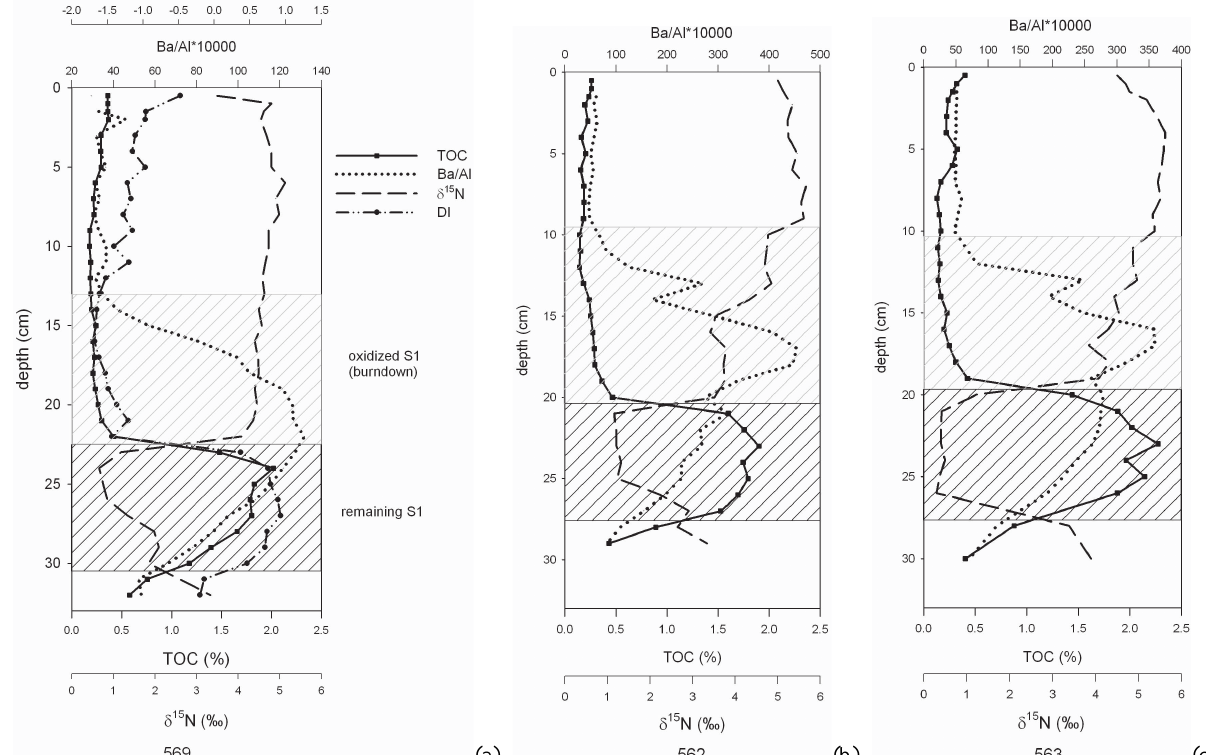
Fig. 3. Downcore plots of total organic carbon (%TOC), barium to aluminum ratios, degradation index (DI) and δ 15 N in multicores #569 (a) , #562 (b) and #563 (c) . S1 sapropel intervals and the burn-down zone above S1 are